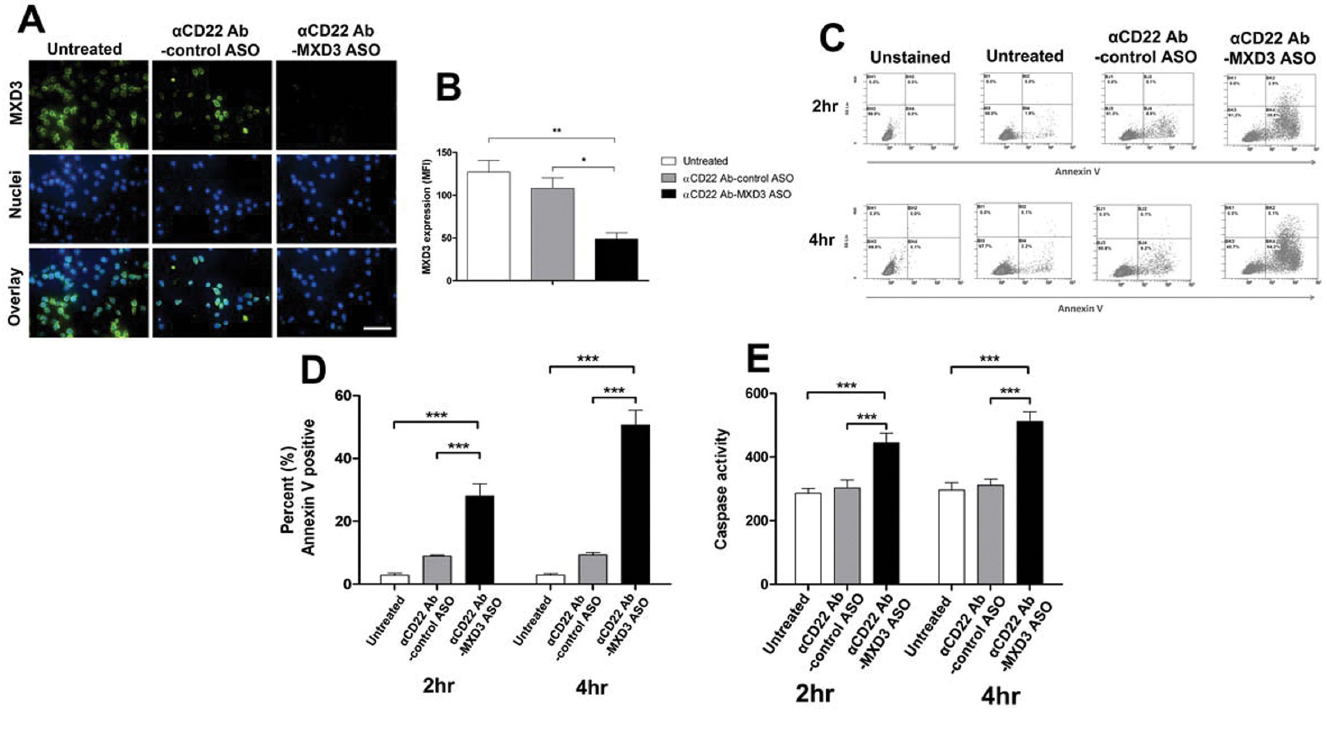
tive) (Supplementary Table S1A).